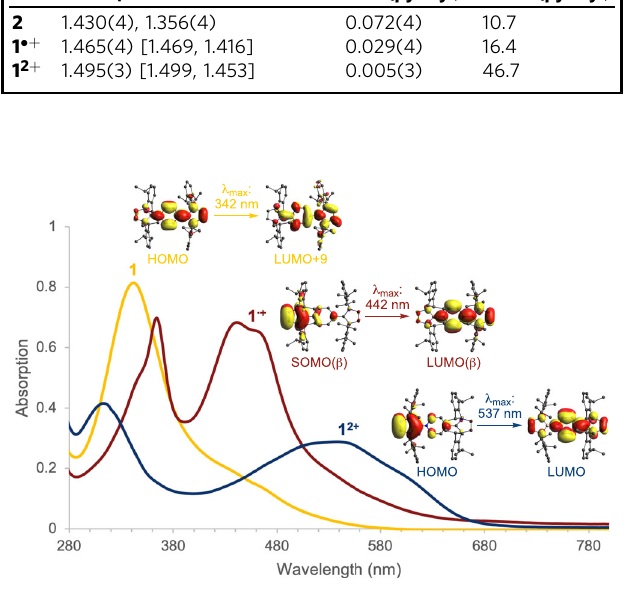
Fig. 7 UV – vis studies. UV – vis spectra of 1 , 1 • + and 1 2 + in CH 2 Cl 2 ; key absorption assignments by